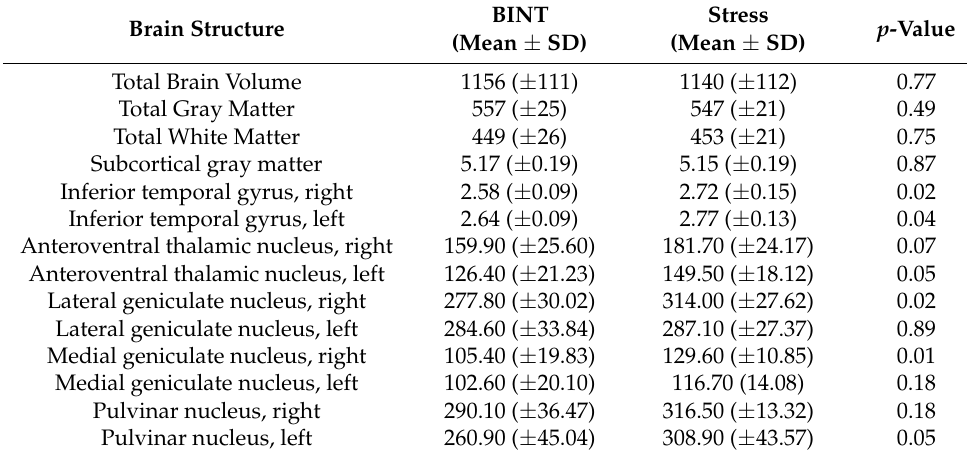
Table 3. Volumetric and cortical thickness